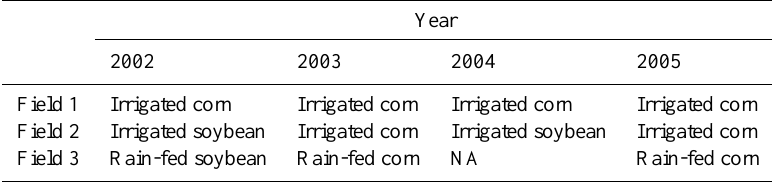
Table 1. Cropping and water management history at Mead study field